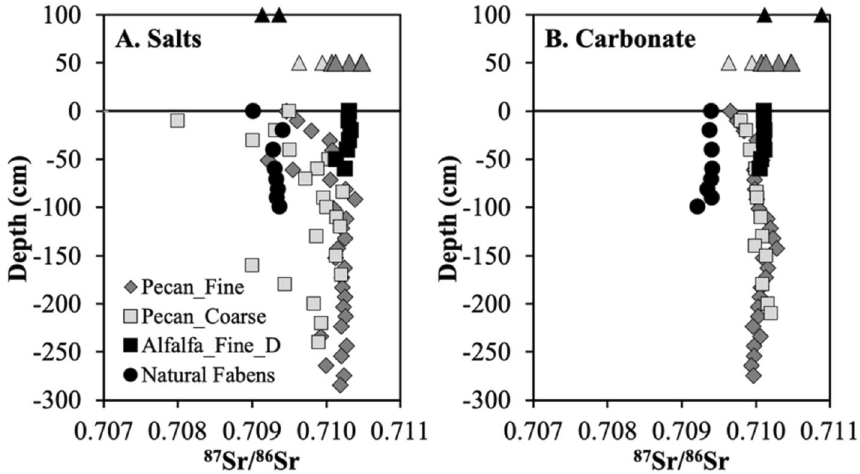
Figure 4. Depth profiles of 87 Sr/ 86 Sr ratios in evaporite salts ( A , water leachable fraction) and pedogenic carbonate ( B , acid leachable fraction) at three agricultural sites (Pecan_Fine and Pecan_Coarse at a pecan orchard, Alfalfa_Fine_D at an alfalfa field) and the natural Fabens site nearby. Also shown are Sr isotope compositions of two dust samples (black triangles, plotted at depths of 100 cm) and irrigation waters (plotted at 50 cm; light triangles for groundwater, IRW_GW and darker triangles for the Rio Grande, IRW_RG).